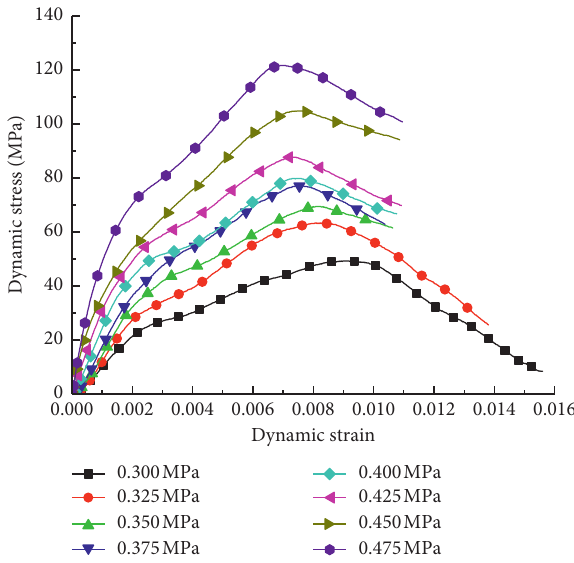
Figure 11: Dynamic stress-strain curves of limestone under dif- ferent loading pressures.